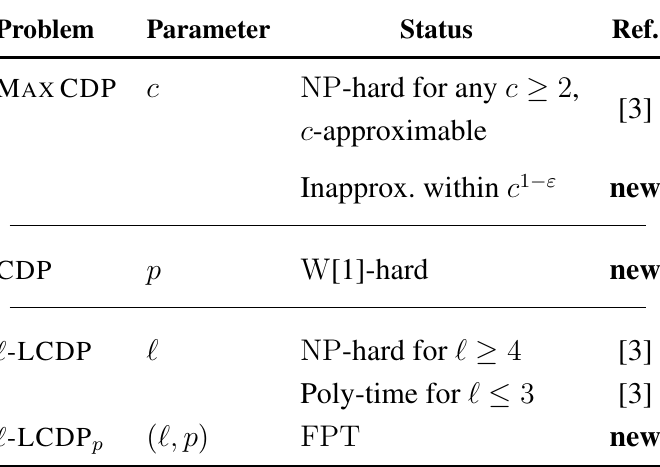
Table 1. Complexity status of M AX CDP